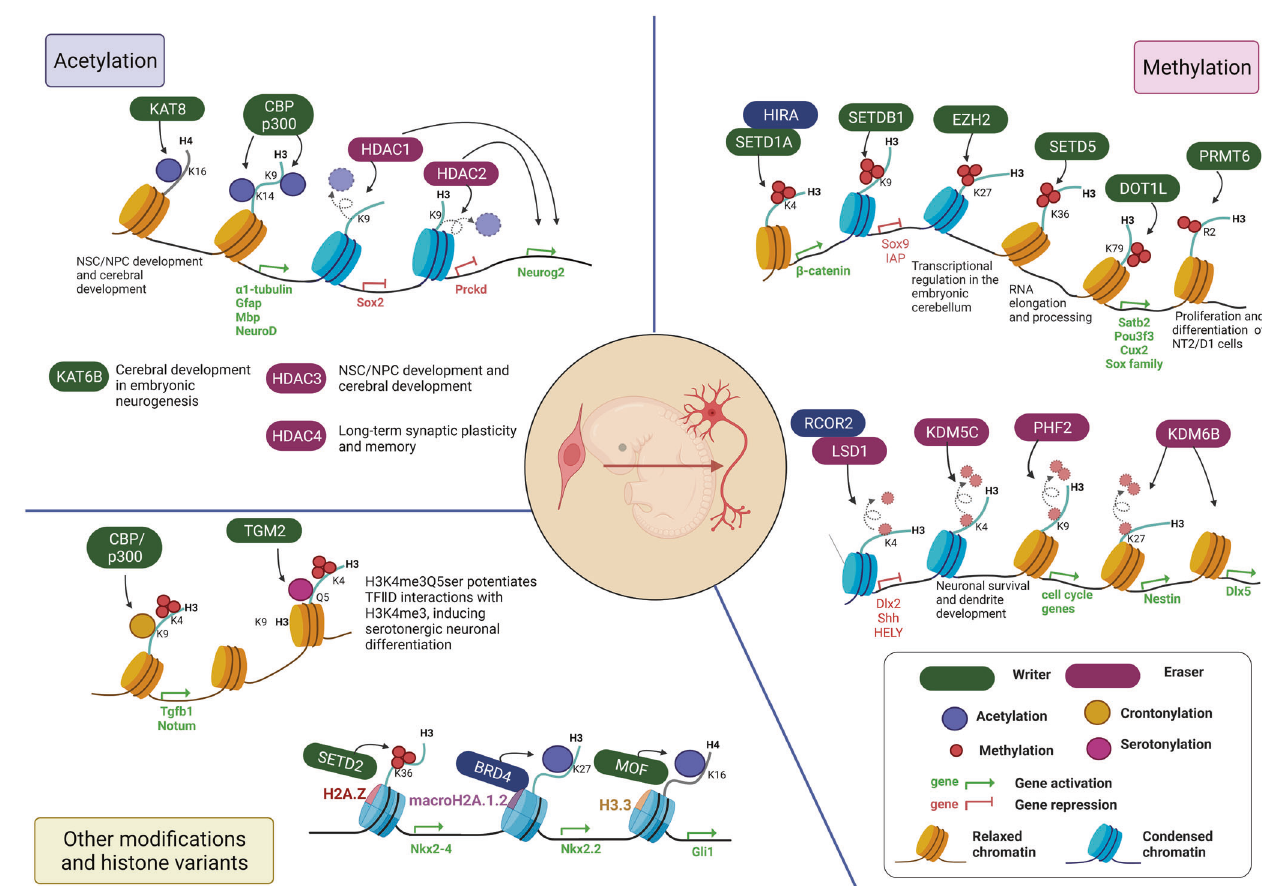
Fig. 3 Histone modi fi cations during embryonic neurogenesis. Histone modi fi cations (e.g., acetylation, methylation, crotonylation, and serotonylation) and other epigenetic regulators (e.g., histone variants) are involved in embryonic neurogenesis. Various HATs (p300/CBP, KAT6B, and KAT8) and HDACs (HDAC1-4) are involved in embryonic neural development by regulating gene expression. Changes in histone methylation by writers (SETD1A/1B, SETDB1, EZH2, SETD5, DOT1L, and PRMT6) or erasers (LSD1, KDM5C, PHF2, and KDM6B) control gene expression, promoting embryonic neurogenesis. Other histone modi fi cations (crotonylation and serotonylation) and histone variants (H2A.X, macroH2A1.2, and H3.3) are involved in embryonic